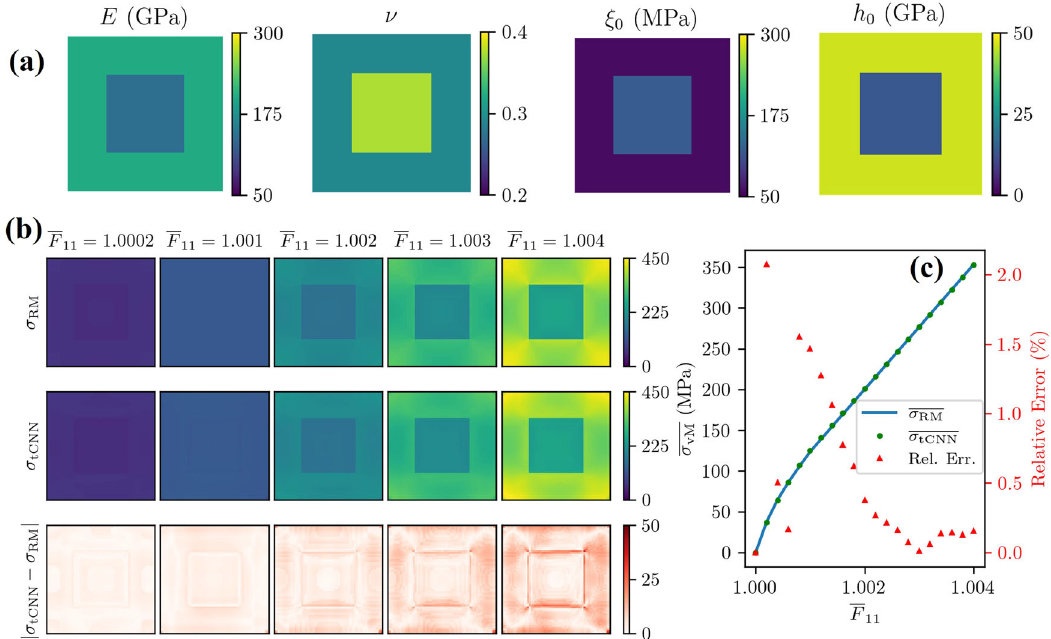
Fig. 7 Square inclusion test microstructure subject to uniaxial extension along the horizontal axis. a Young ’ s modulus E , Poisson ’ s ratio ν , initial fl ow resistance ξ 0 , linear isotropic hardening modulus h 0 . b Results for σ RM (above), σ tCNN (middle), ∣ σ tCNN − σ RM ∣ (below) (all MPa), at different F 11 . c σ RM (blue curve), σ tCNN (green points), and relative error (red triangles) given by 100 ð σ tCNN (cid:3) σ RM Þ = σ RM versus F 11 hardening, with ξ 0 the initial fl ow resistance, and h 0 the isotropic hardening modulus. the deviatoric The viscoplastic model is implemented in the simulation software toolkit DAMASK 5 . This toolkit is also used for numerical solution of the corresponding quasi-static mechanical boundary- value problem on periodic grain microstructures based on spectral (i.e., Fourier) methods.